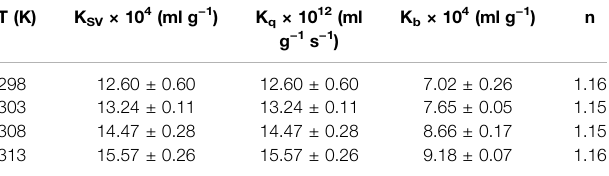
TABLE 5 | The Stern-Volmer quenching constant (K SV ), quenching rate constant (Kq), binding constant (K b ) and number of binding site (n) of the interaction between HSA and TBESD at different temperatures (Mean ± SD, n = 3).